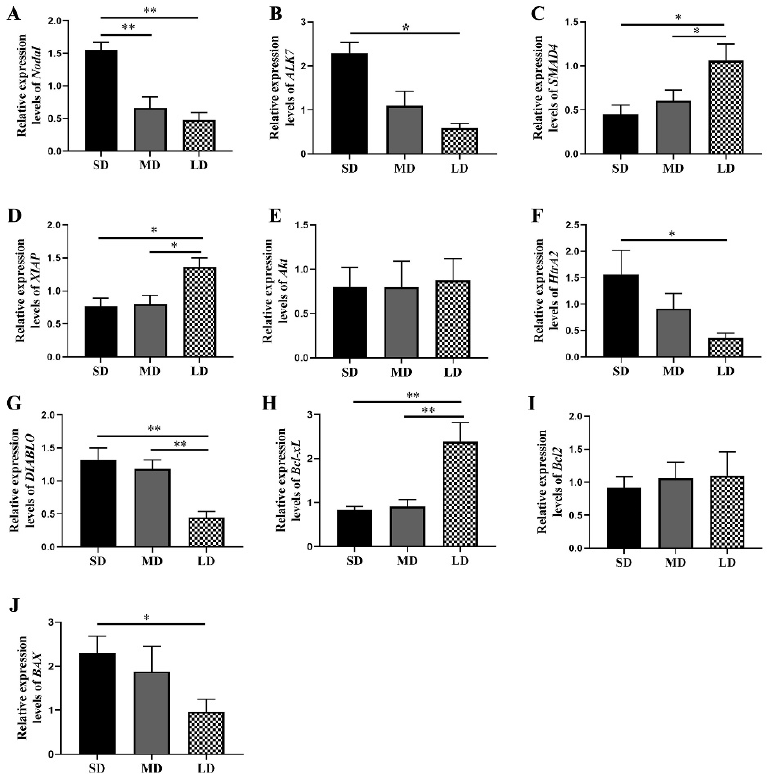
Figure 6. Key gene expression levels in the Nodal/ALK7 signaling pathway in the ovaries of Phodopus sungorus under three photoperiod conditions. ( A ) Nodal , ( B ) ALK7 , ( C ) SMAD4 , ( D ) XIAP , ( E ) Akt , ( F ) HtrA2 , ( G ) DIABLO , ( H ) Bcl-xL , ( I ) Bcl2 , and ( J ) BAX . Values are means ± SEM. n = 6. SD, short daylight; MD, moderate daylight; LD, long daylight. * p < 0.05, ** p < 0.01.